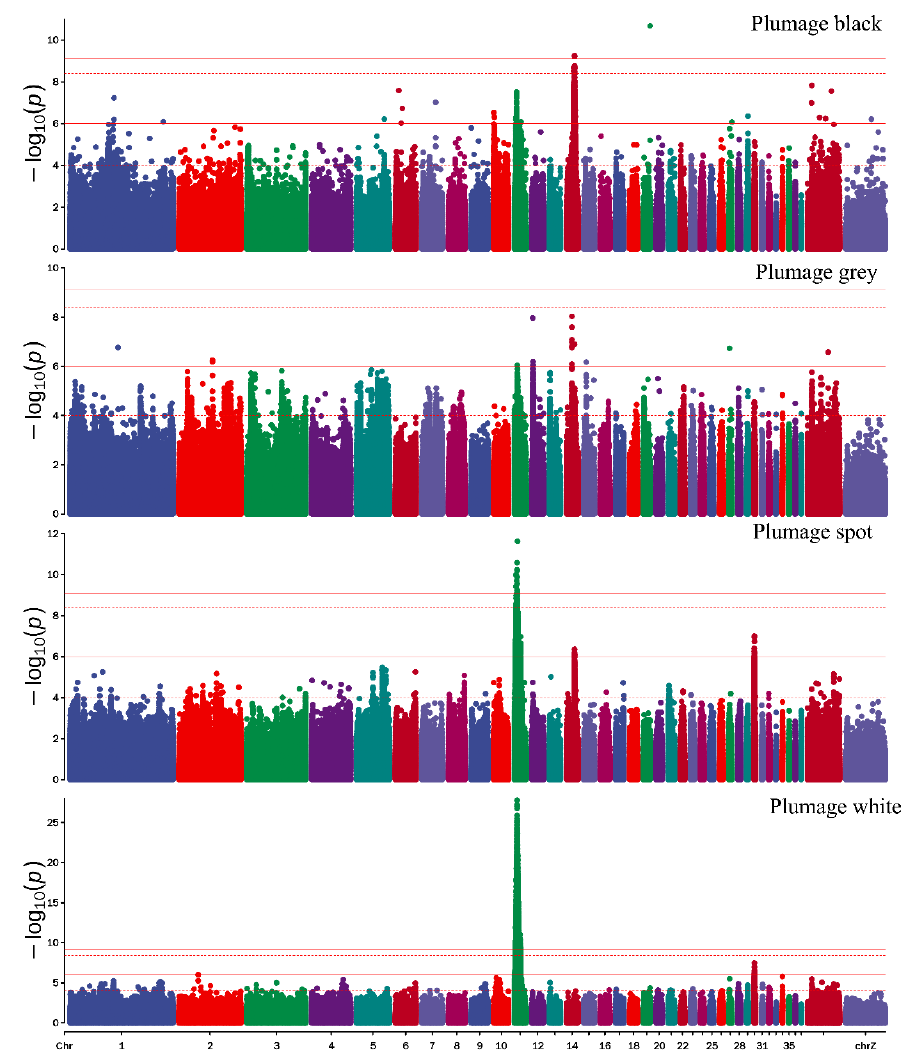
Figure 4. Manhattan plot of four different color plumage phenotypes. The lines from top to bottom in the Manhattan plot represent thresholds of 7.897699 × 10 − 10 , 3.948849 × 10 − 9 , 1 × 10 − 6 and 1 × 10 − 4 , respectively.